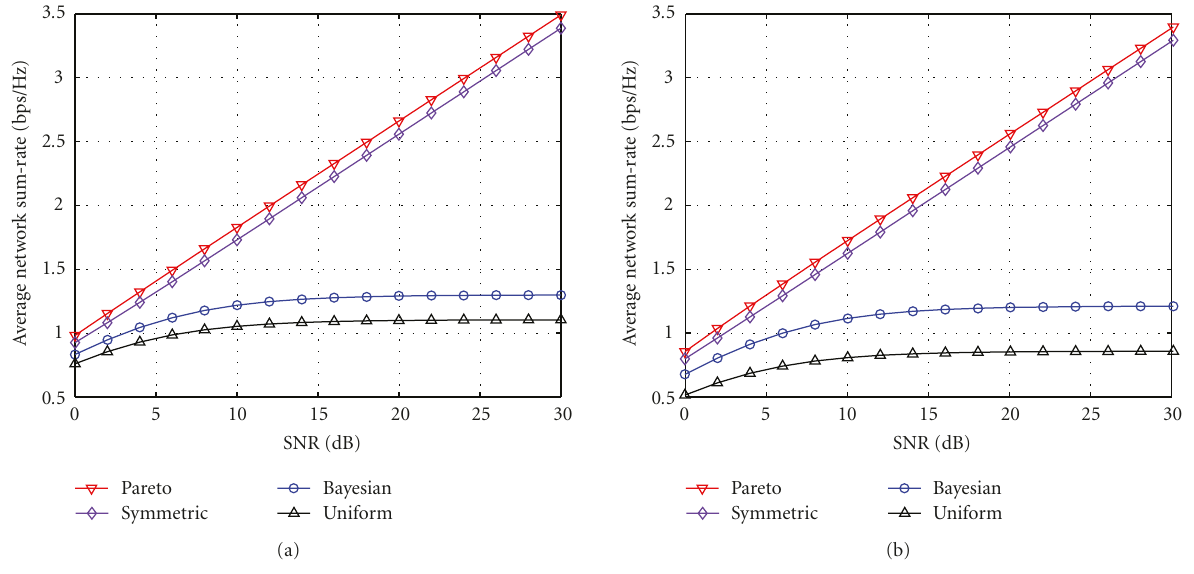
Figure 2: Average network sum-rate. (a) g − = 1, g + = 3, (b) g − = 1, g + =